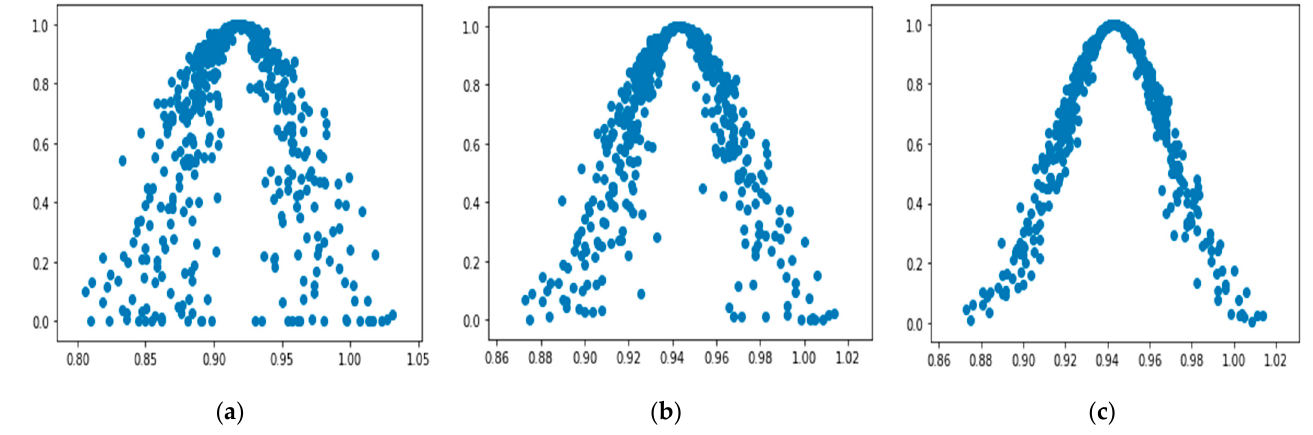
Figure 2. Process diagram of cloud weight correction. ( a ) Experts score for the first time; ( b ) experts score for the second time; ( c ) experts score for the third time.